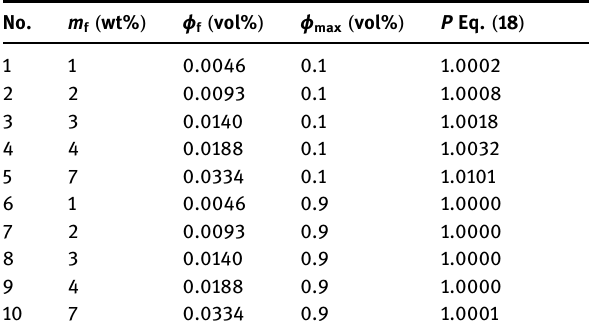
Table 3: The variation in “ P ” at di ff erent levels of “ ϕ f ” and “ ϕ max ” for PDMS/MWCNT